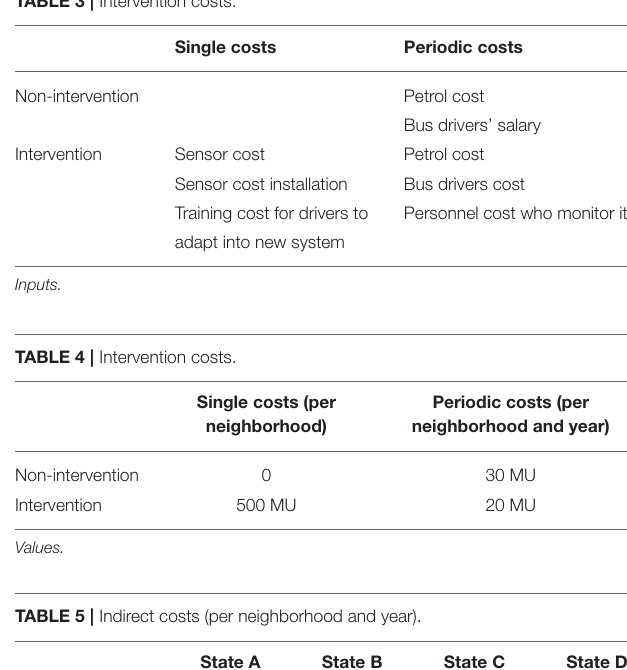
TABLE 6 | Intervention and non-intervention costs and effects per